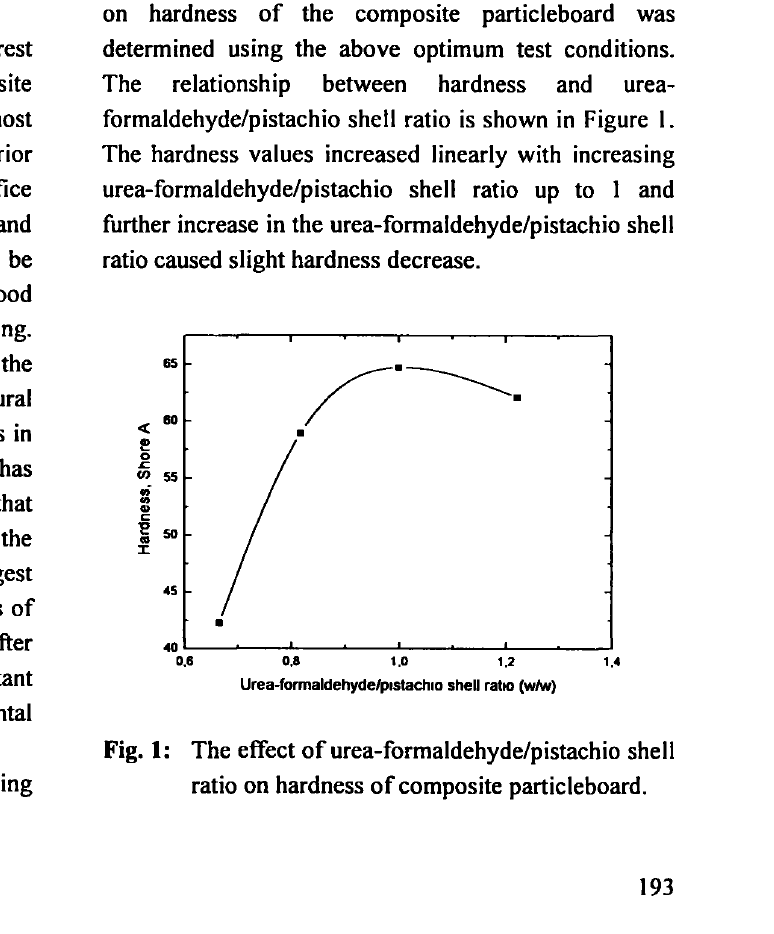
Fig. 1: The effect of urea-formaldehyde/pistachio shell ratio on hardness of composite